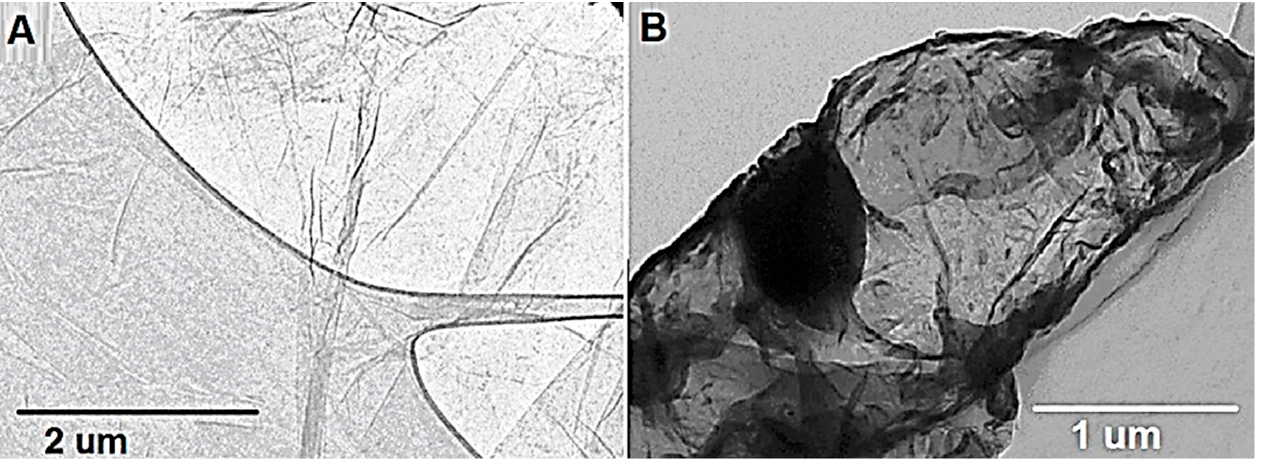
Figure 7. Transmission electron microscopy images of ( A ) monolayer graphene oxide nanosheets; and ( B ) epoxy and reduced graphene oxide nanocomposite. Reprinted with permission from [113]. 2013, Elsevier.